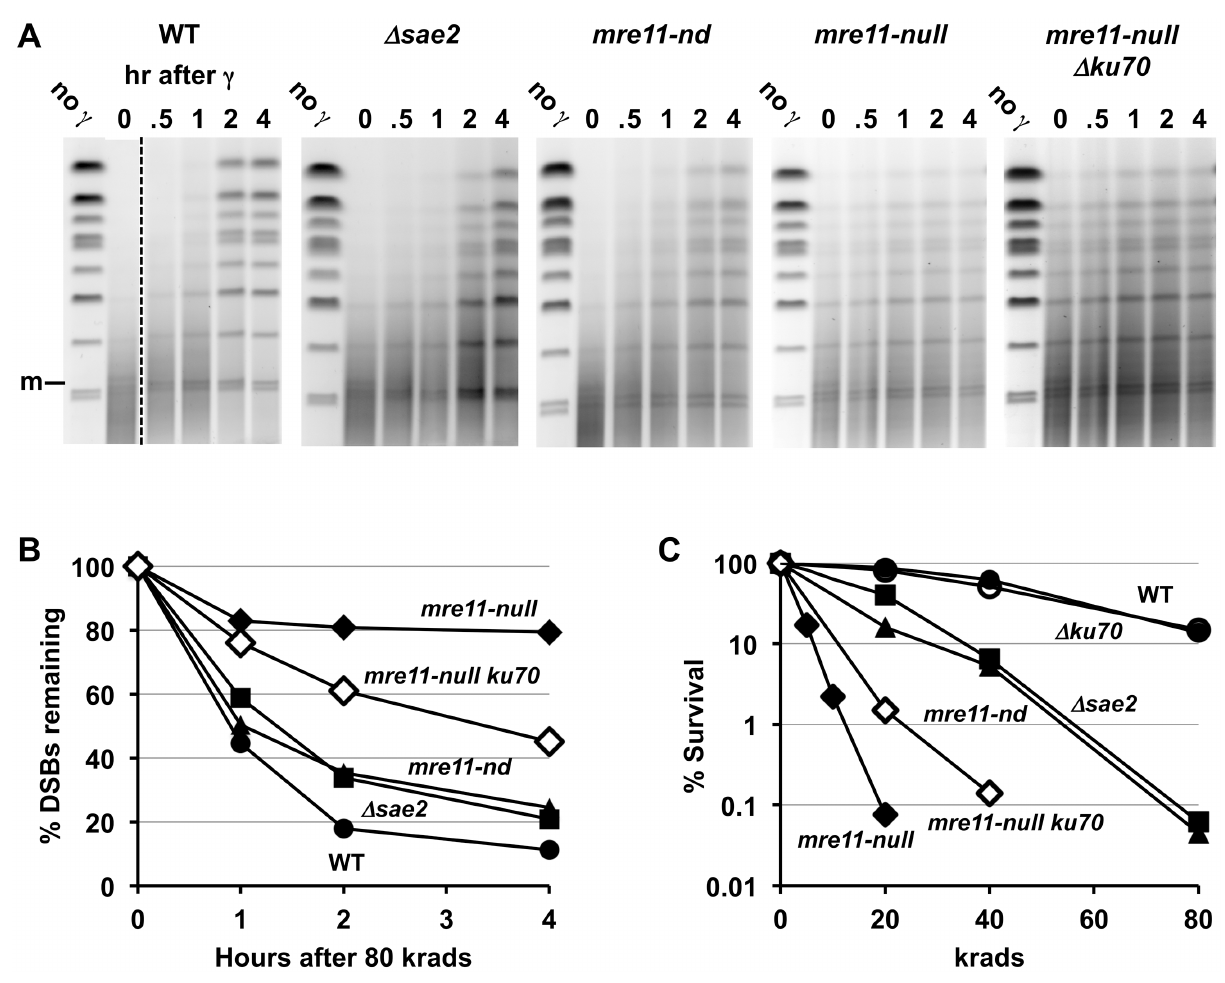
Figure 5. Impact of D sae2 and mre11-nd mutations on repair of IR-induced DSBs. A. Genomic chromosomal changes in response to 80 krad and subsequent repair. Some of the lanes for the WT were removed to provide matching time course information between WT and mutants. Note the appearance of the broken circular chromosome (m) at time ‘‘0’’ after irradiation, just above the lowest two bands. The PFGE gels were stained with SYBR Gold to identify the DNA. B. Repair of DSBs following 80 krad. Quantitation of DSBs is derived from an analysis of broken chromosomes in the SYBR Gold stained PFGE gels of (A). Analysis of the frequency of DSBs and repair are described in [33]. WT, circle; D sae2 , square; mre11-nd , triangle; mre11-null , diamond; mre11-null D ku70 , open diamond. C. Survival of irradiated cells. Following irradiation, cells were diluted and plated to YEPD and survival was determined based on number of colonies. WT, circle; D ku70 , open circle; D sae2 , square; mre11-nd , triangle; mre11-null , diamond; mre11- null D ku70 , open